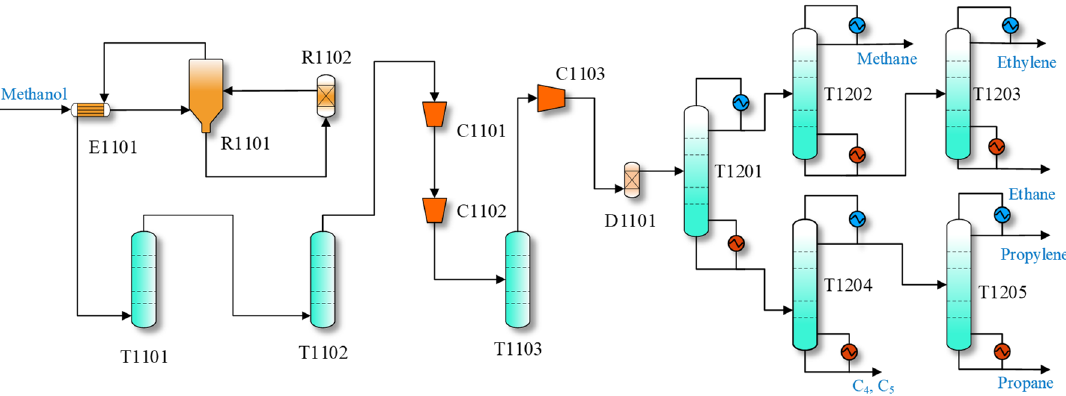
Figure 1. MTO process with front-end dethanizer.